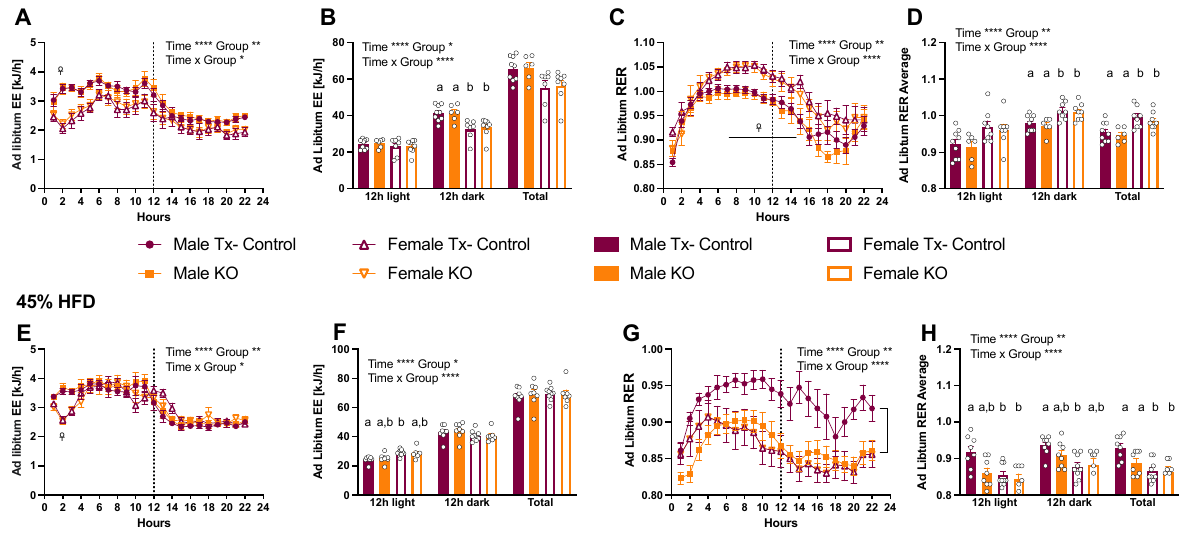
Figure 5. CTR depletion in microglia decreases respiratory exchange ratio (RER) in HFD male KO mice but has no effect on energy expenditure (EE). Ad libitum EE and RER measurements in Tx ‐ controls and KO male and female mice fed chow (cohort 2; A – D ) and 45% HFD (cohort 3; E – H ). Hourly values are displayed as mean ± SEM n = 6 − 10 per group. Data were analyzed using a two ‐ way ANOVA with repeated measures for genotype (Gen) and time * p < 0.05, ** p < 0.01, **** p < 0.0001. ☥ p < 0.05 male vs. female. Data points with differing superscript letters (a, b) differ from each other by p = 0.05 or less after Tukey’s post ‐ hoc test. The shaded grey area indicates the dark phase.